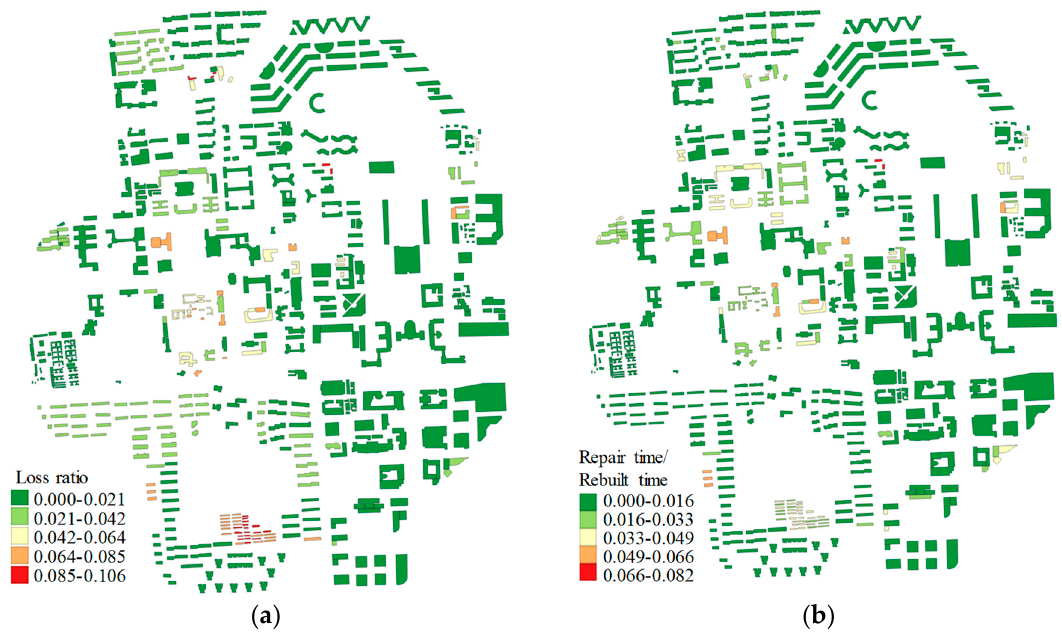
Figure 9. Distribution of median ( a ) building loss ratios and ( b ) repair/rebuild time for Tsinghua Figure9. Distributionofmedian( a )buildinglossratiosand( b )repair / Campus.